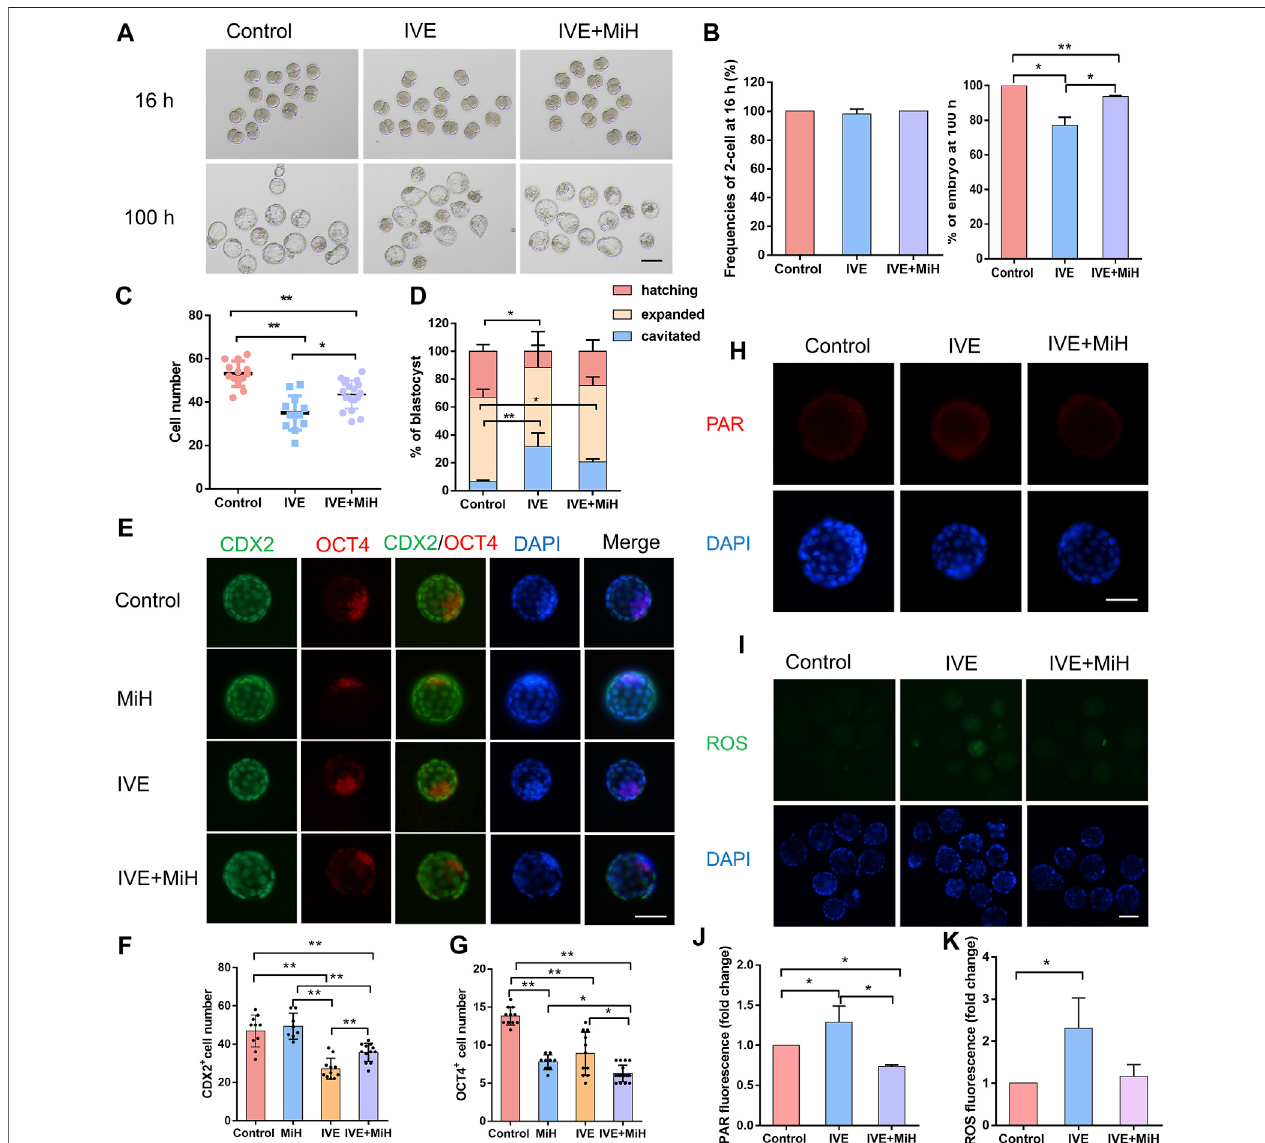
FIGURE3| PARP1inhibitorscouldprotectpreimplantationmouseembryosfromexposuretoexternalenvironment. (A,B) Representativeimagesandfrequencies of 2-cell embryo observed at 16 h and blastocyst at 100 h after fertilization. Control, zygotes were transferred into incubators soon after washing and cultured in KSOM conditiontill100 h;IVEandIVE+MiH,zygoteswereexposedtoexternalenvironmentfor1 handthenweretransferredintoincubatorandculturedinKSOMwithout(IVE) or with MiH supplemented (IVE+MiH). Bar (cid:1) 100 μ m. (C) Comparison of cell numbers of blastocyst at 100 h. (D) Ratios of cavitated, expanded and hatching blastocystsat 100 h.46,49,47embryosweretotally countedinControl,IVEand IVE+MiHgroups. (E – G) Immuno fl uorescentimages ofblastocystsandcellnumbers in each blastocyst at 100 h. CDX2 (green) and OCT4 (red) were used as markers for TE and ICM separately. Bar (cid:1) 50 μ m. N (Control) (cid:1) 12, n (IVE) (cid:1) 11, n (IVE+MiH) (cid:1) 18. (H) Staining images of expanded blastocysts in the three groups for PAR. Bar (cid:1) 50 μ m. (I) Fluorescent images of ROS for expanded blastocysts. Bar (cid:1) 100 μ m. (J,K) Quanti fi cation intensity levels for PAR (J) and ROS (K) in in Control, IVE and IVE+MiH groups. Data are presented as mean ± SD in three independent experiments and student ’ s t tests are used for statistical analysis. p 0.01 < p < 0.05; pp p < 0.01; no labeling indicates no statistical signi fi cance.